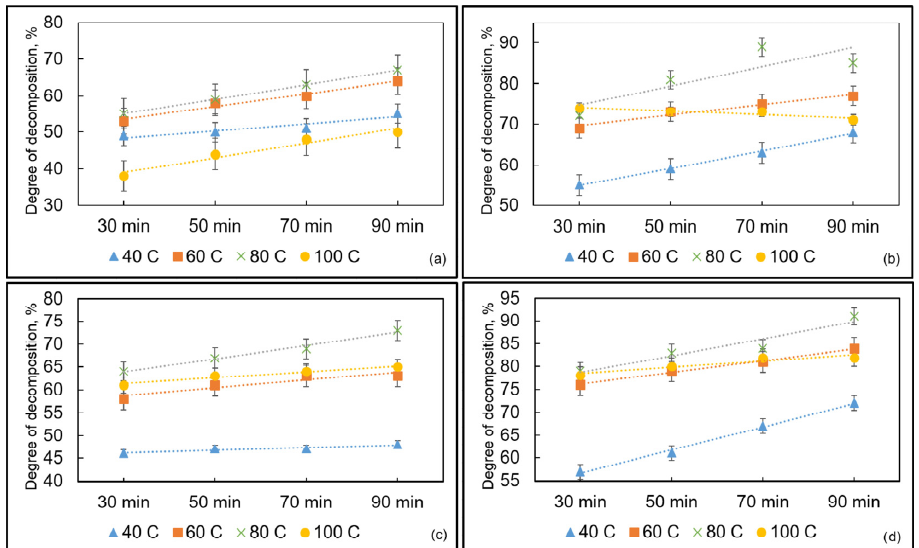
Figure 2. Plots of degree of composition vs. time at various conditions: ( a ) PS-CD/HA ratio = 1/1, pH = 1.92; ( b ) PS-CD/HA ratio = 1/2, pH = 1.92; ( c ) PS-CD/HA ratio = 1/1, pH = 1.5; ( d ) PS-CD/HA ratio = 1/2, pH =